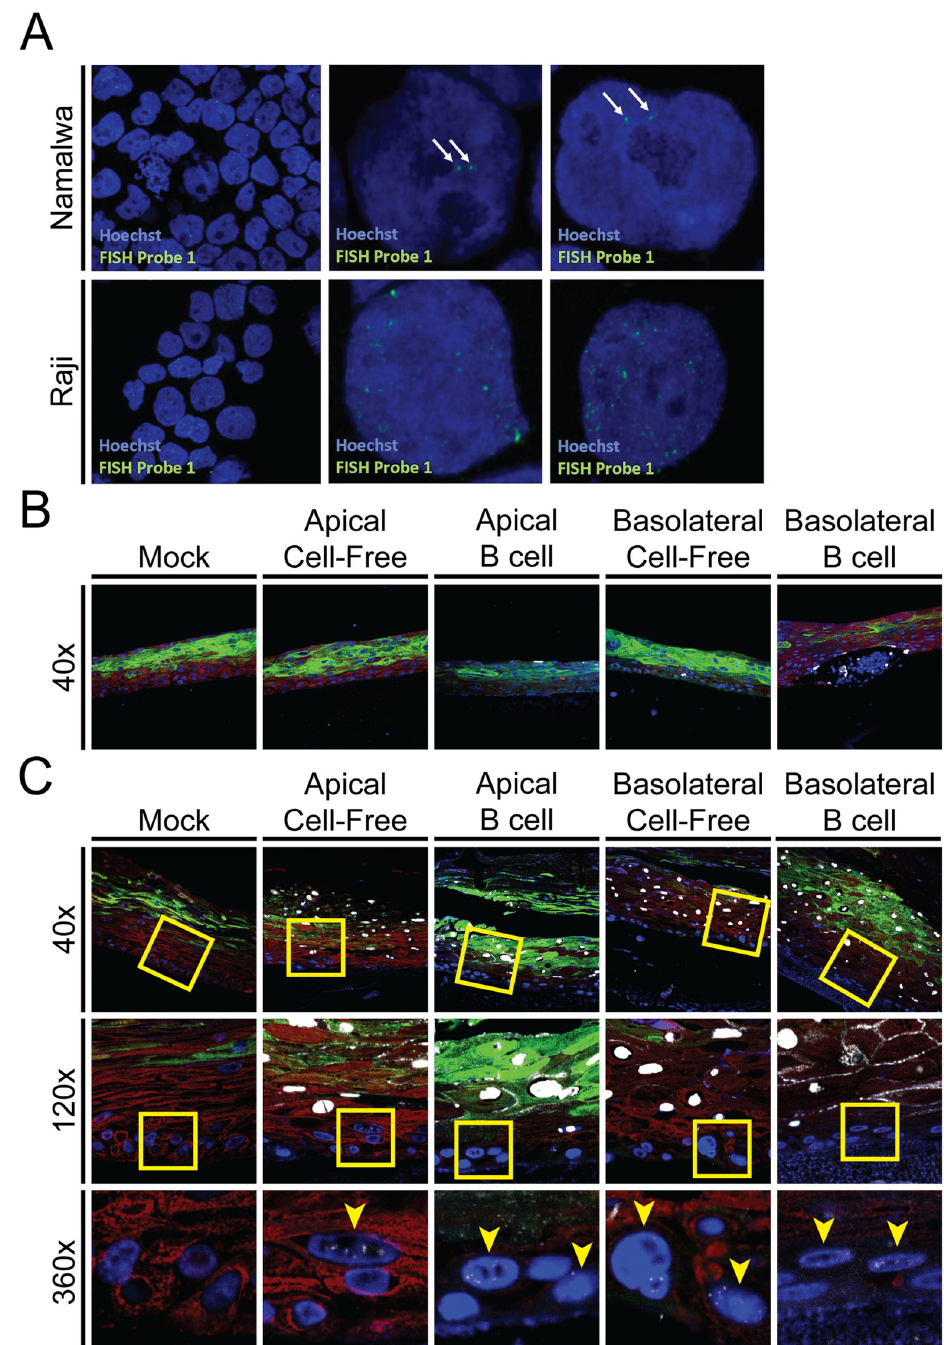
Fig 6. Cell-free and cell-associated EBV can infect cells in both the basal and suprabasal layers when added either to the apical or the basal surface of organotypic cultures. In situ hybridization probes targeting the EBV genome were validated to be specific and sensitive by detecting exactly two copies of the EBV genome in Namalwa B cells (A) . Gingiva organotypic cultures were infected by B cell-derived cell-free virus or virus-producing B cells at the apical or basolateral surface as indicated. Organotypic cultures were collected at 1 DPI (B) and 5 DPI (C) . Sections were probed for cytokeratin 10 (green), cytokeratin 5 (red), cell nuclei (Hoechst, blue), and viral DNA (white). EBV was detected by in situ hybridization in undifferentiated epithelial cells (CK5 (+) CK10 (-) cells). (C) Yellow squares designate areas imaged with enhanced magnification. Yellow arrowheads indicate cells in the lowest layers of the organotypic culture with discrete nuclear puncta. Micrographs are representative of three biological replicates from two distinct donor